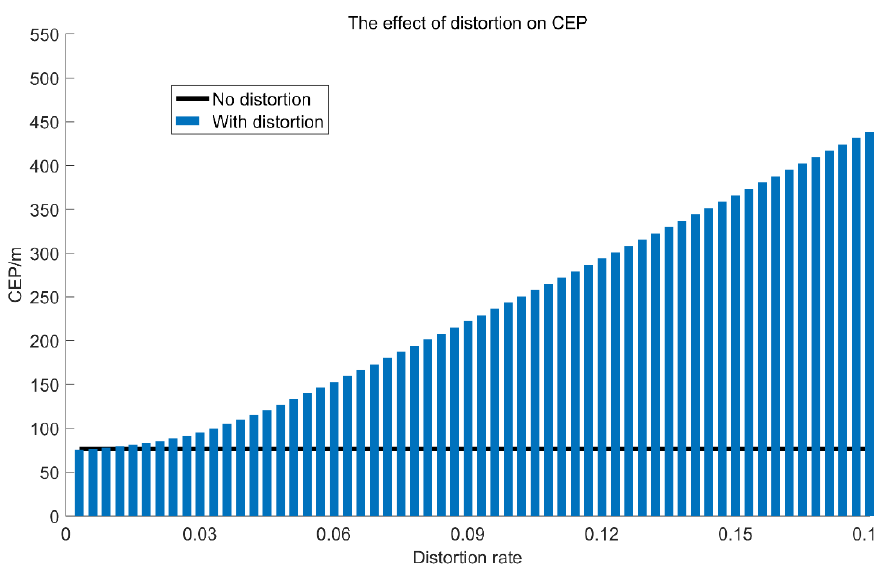
Figure 14. Schematic diagram of the positioning error caused by image